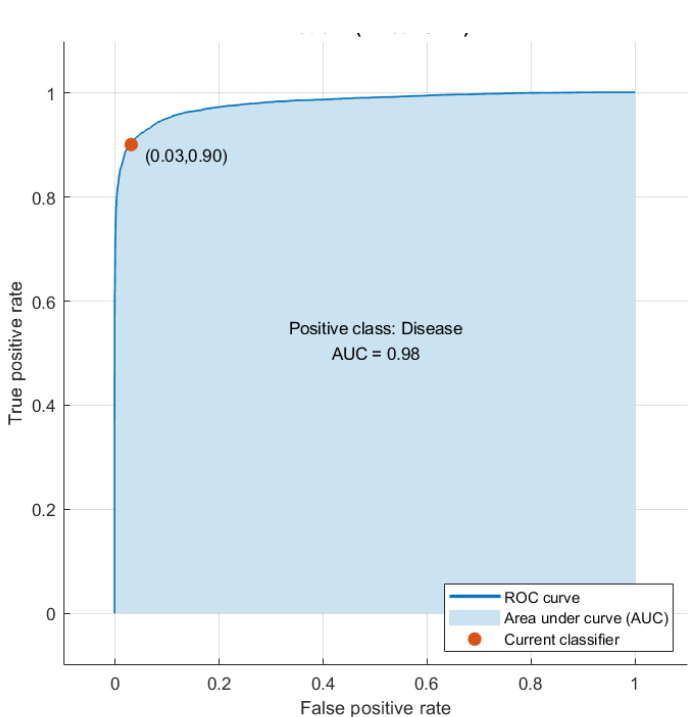
Figure 11. ROC curve and the AUC of the SVM classifier trained with integrated features of the third fusion stage (fusing of the second fusion stage features of the three CNNs using DCT (2000 features)). Table 2. The efficiency indicators (%) attained with the three GabROP classifiers using the 2000 DCT features.